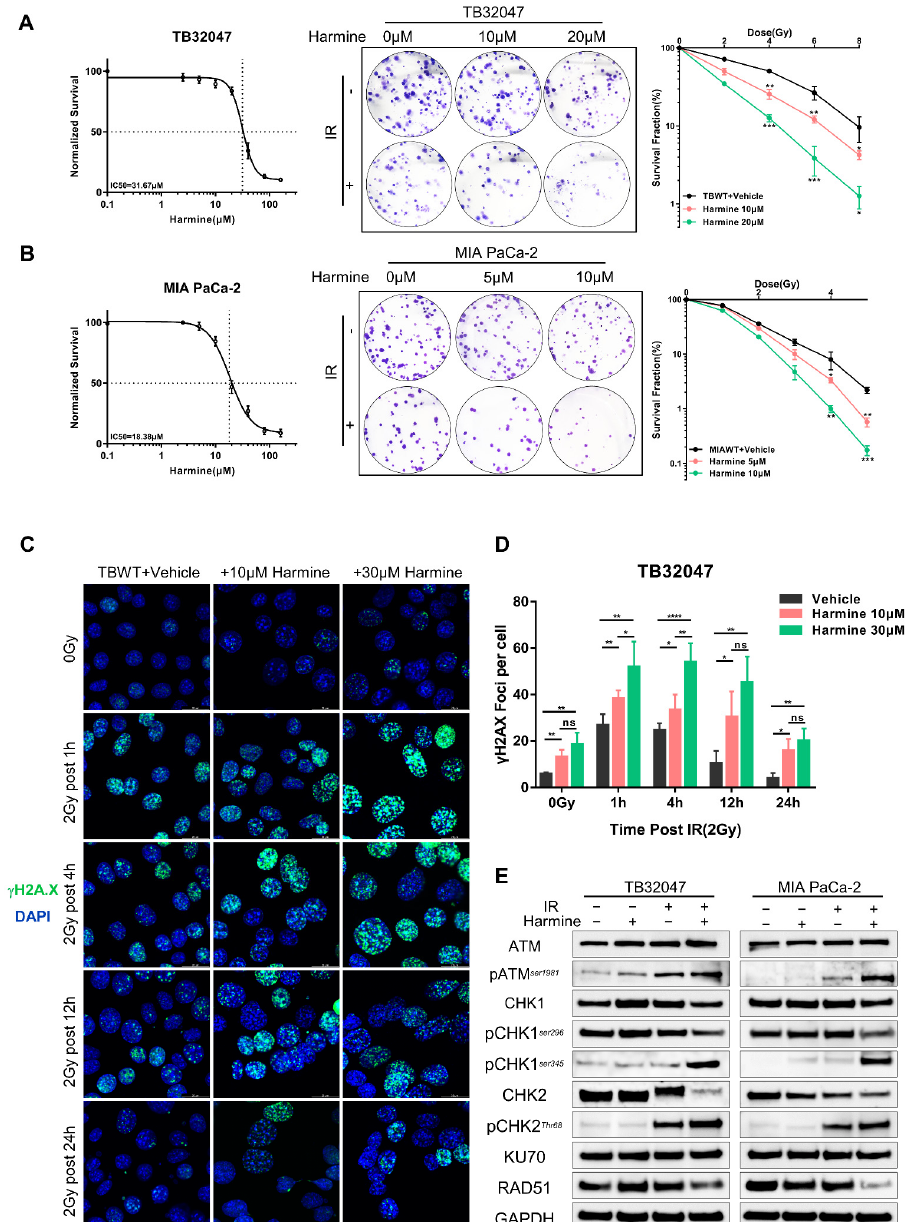
Figure 4. Targeted inhibition of DYRK1A promotes radiosensitivity in pancreatic cancer. ( A , B ) Dose– response curves of TB32047 ( A ) and MIA PACA-2 ( B ) wild-type cells to Harmine ( left ). TB32047 and MIA PACA-2 wild-type cells were treated with the indicated concentrations of inhibitors along with different doses of radiation and then subjected to clonogenic assays. Representative images of three independent experiments ( n = 3) are shown ( middle ). The colony numbers were counted, normalized, and statistically analyzed ( right ). Data are presented as mean ± SD. *, p < 0.05; **, p < 0.01 and ***, p < 0.001 by 2-tailed unpaired Student’s t test. ( C ) Immunofluorescence of TB32047 wild-type cells was treated with the indicated concentrations of inhibitors at different time points with 2 Gy irradiation. Representative images of three independent experiments ( n = 3) are shown. (Blue-DAPI, Green- γ H2A.X. Scale bar: white, 20 µ m). ( D ) Statistical analysis of γ H2A.X foci per cell. Number of foci was counted and normalized, and a minimum of 200 cells were analyzed. *, p < 0.05; **, p < 0.01; and ****, p < 0.0001 by 2-tailed unpaired Student’s t test. ns. not significant. ( E ) Western blot of TB32047 and MIA PACA-2 treated with inhibitor alone, X-rays alone, or their